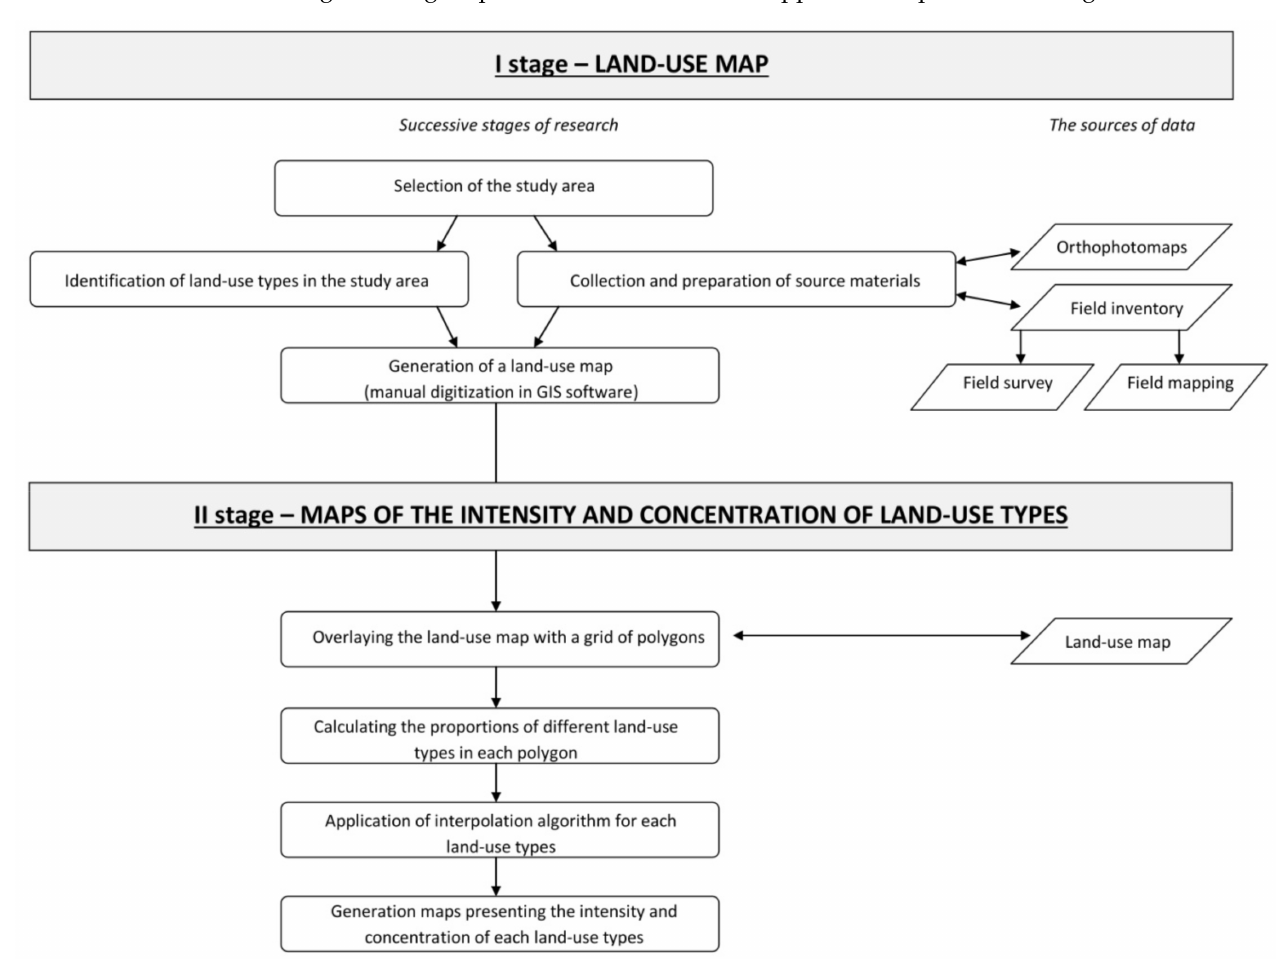
Figure 2. Successive stages of research for high-precision land-use analyses in the context of large- scale